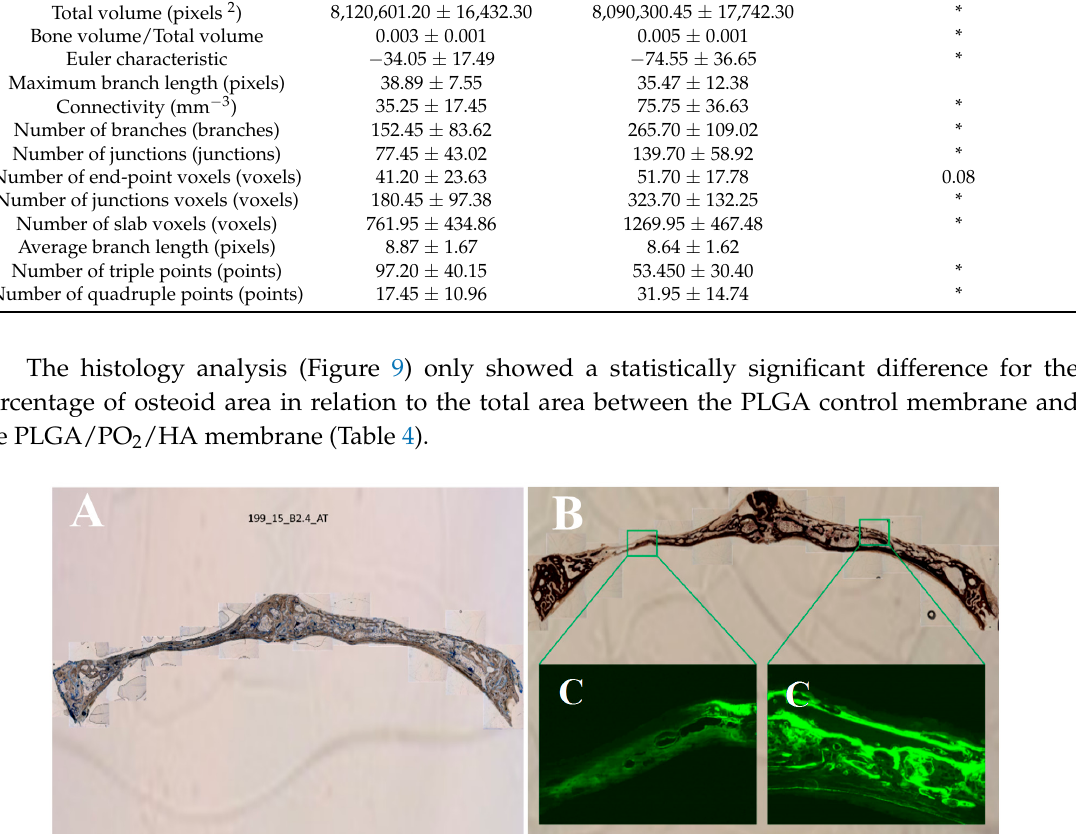
Table 3. Bone J analysis plugins. (* p ≤ 0.05).